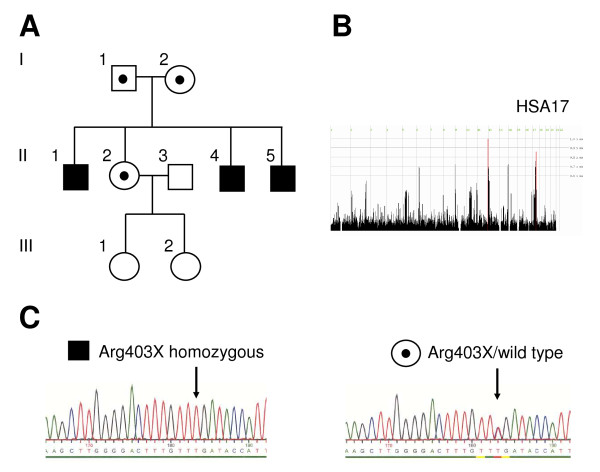
Genetic studies. A, Pedigree of the OI family. Black pedigree symbols, affected brothers, homozygous; symbols marked by black dots, unaffected family members that are heterozygous for the mutation; unmarked symbols, unaffected family members that were not available for analysis. B, Genome wide plot of Homozygosity Mapper. Red bars indicate regions with extended ROH at chromosomal regions 11q25 and 17q21.2, shared by the three affected brothers. Homozygosity Score threshold 0.8; HSA, homo sapiens chromosome. C, Sequencing results. Parts of FKBP10 exon 7 are shown. Left side, OI patient II1 homozygous for Arg403X; right side, healthy sister (II2) heterozygous for Arg403X.